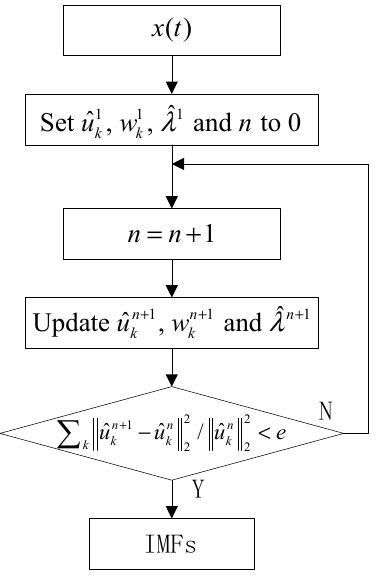
Figure 1. The flow diagram of VMD.